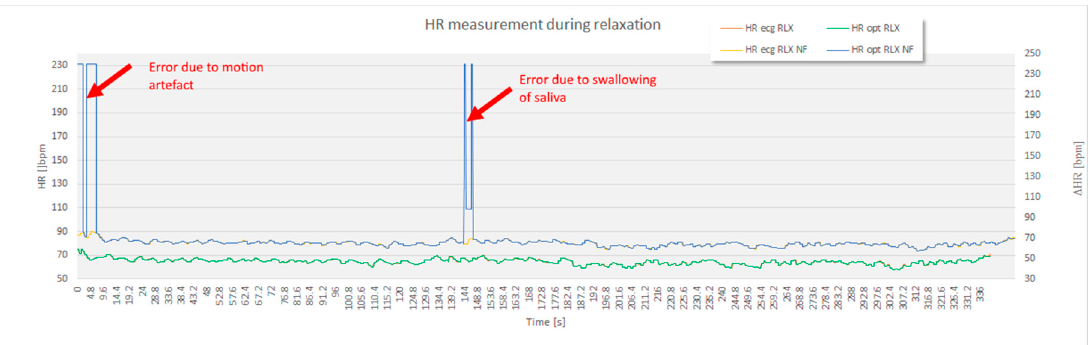
Figure 7. The non-filtered signal (NF) also included several disturbances caused by environmental factors. For the purpose of further analytical processing of the HR and time domain HRV markers ( AVNN , SDNN , rMSSD , pNN20 and pNN50 ), sections where the differences between the instantaneous ECG HR and US HR signal above 15 beats per minute were filtered out. The image demonstrates error in the US signal at the beginning of the recording while the subject was still moving, and error due to swallowing of saliva in the middle of the recording.